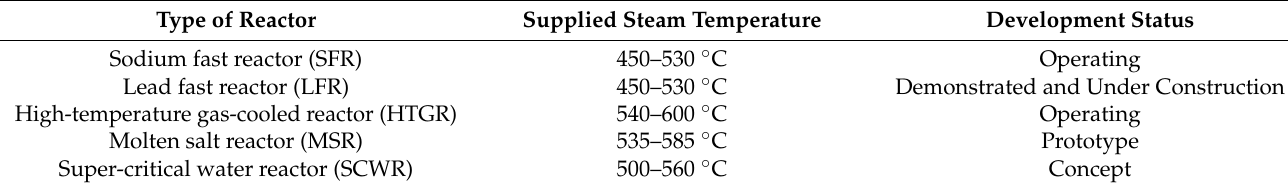
Table 6. Non-water-cooled reactor classes and operating steam